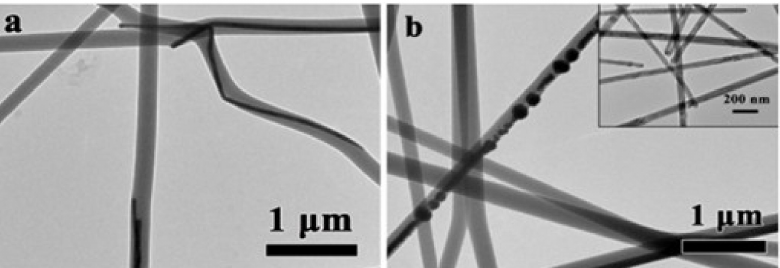
Figure 2. ( a , b ) TEM images of Ag NWs/PVA nanofibers with 75 µ L Ag nanowire addition, the inset in ( b ) is a TEM image of Ag NWs in a PVA pre-electrospinning solution. Reprinted with permission from ref. [33]. Copyright 2017